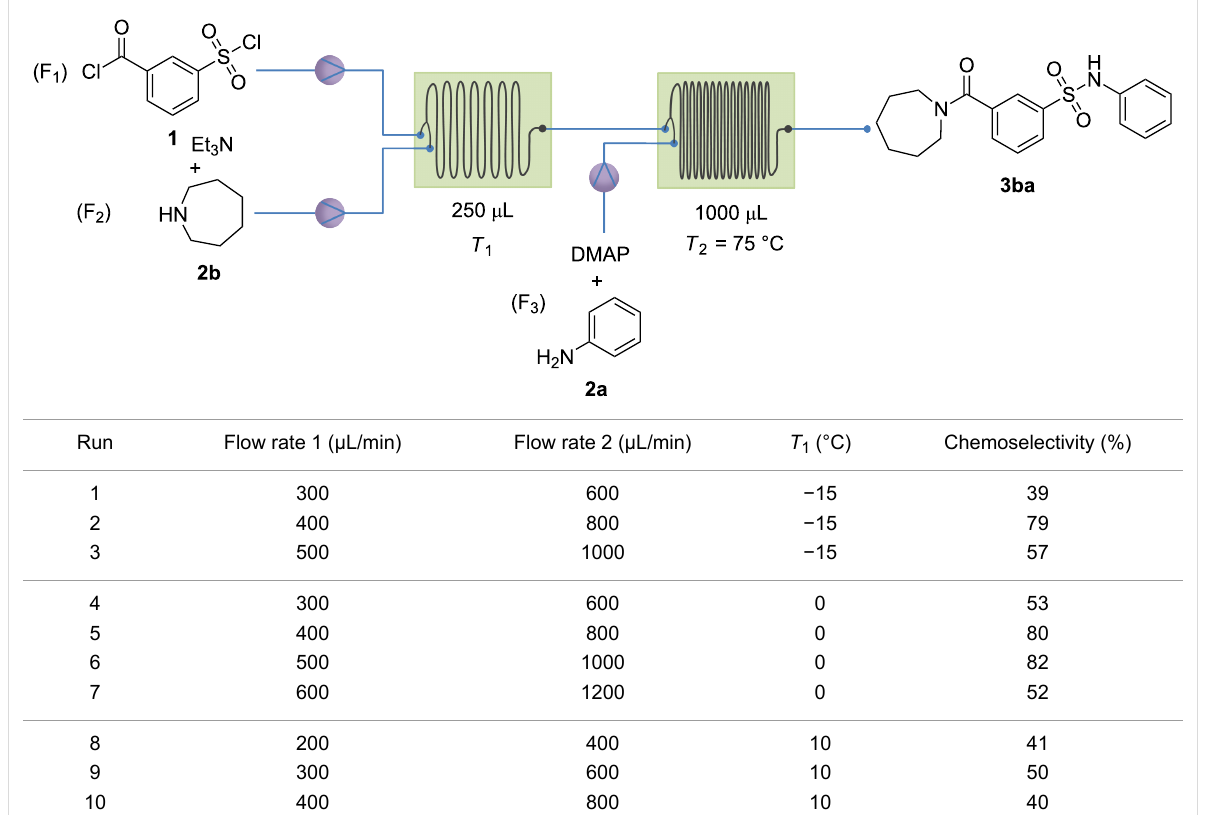
Table 3: Screening results of the different conditions for the best chemoselectivity with azepane and aniline as (F 2 ) and (F 3 ), respectively.